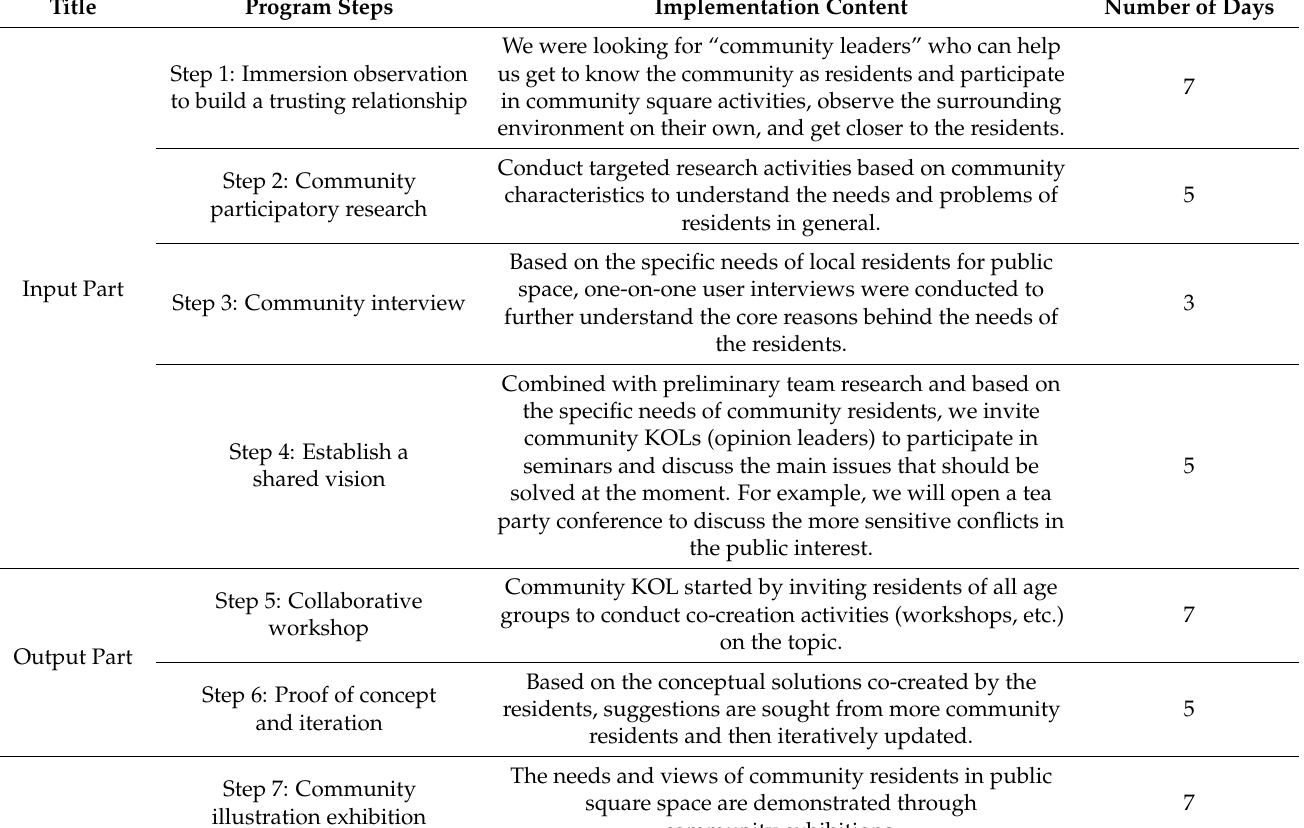
Table 1. Intergenerational project